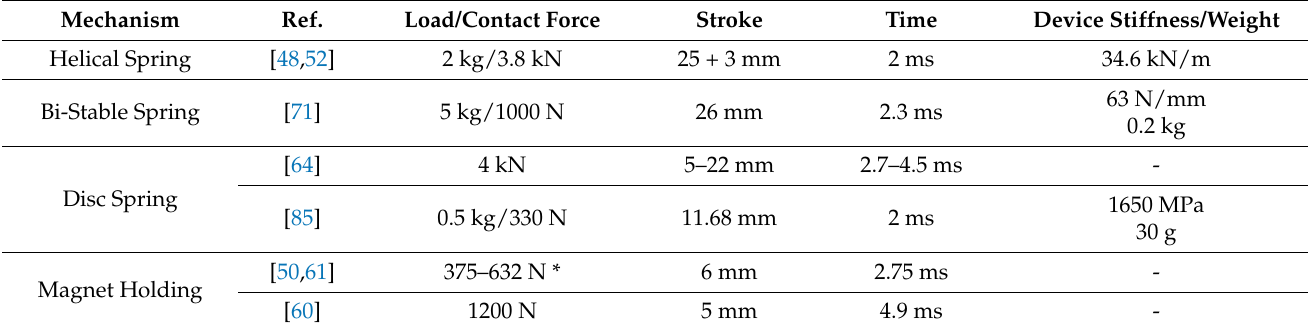
Table 2. Different holding mechanisms’ performance in the